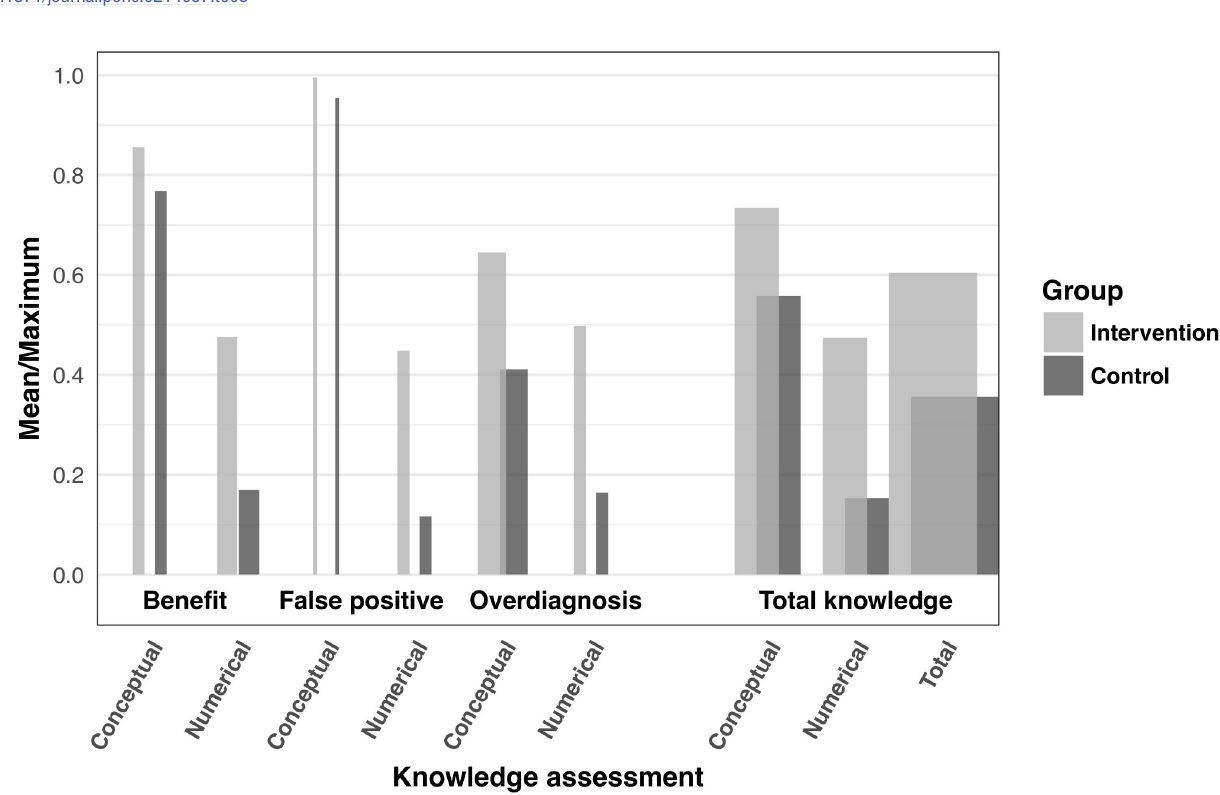
Fig 2. Relative mean scores on knowledge subscales, with respect to the maximum available score. Bars width indicate the contribution of the available marks for each subscale to the total available